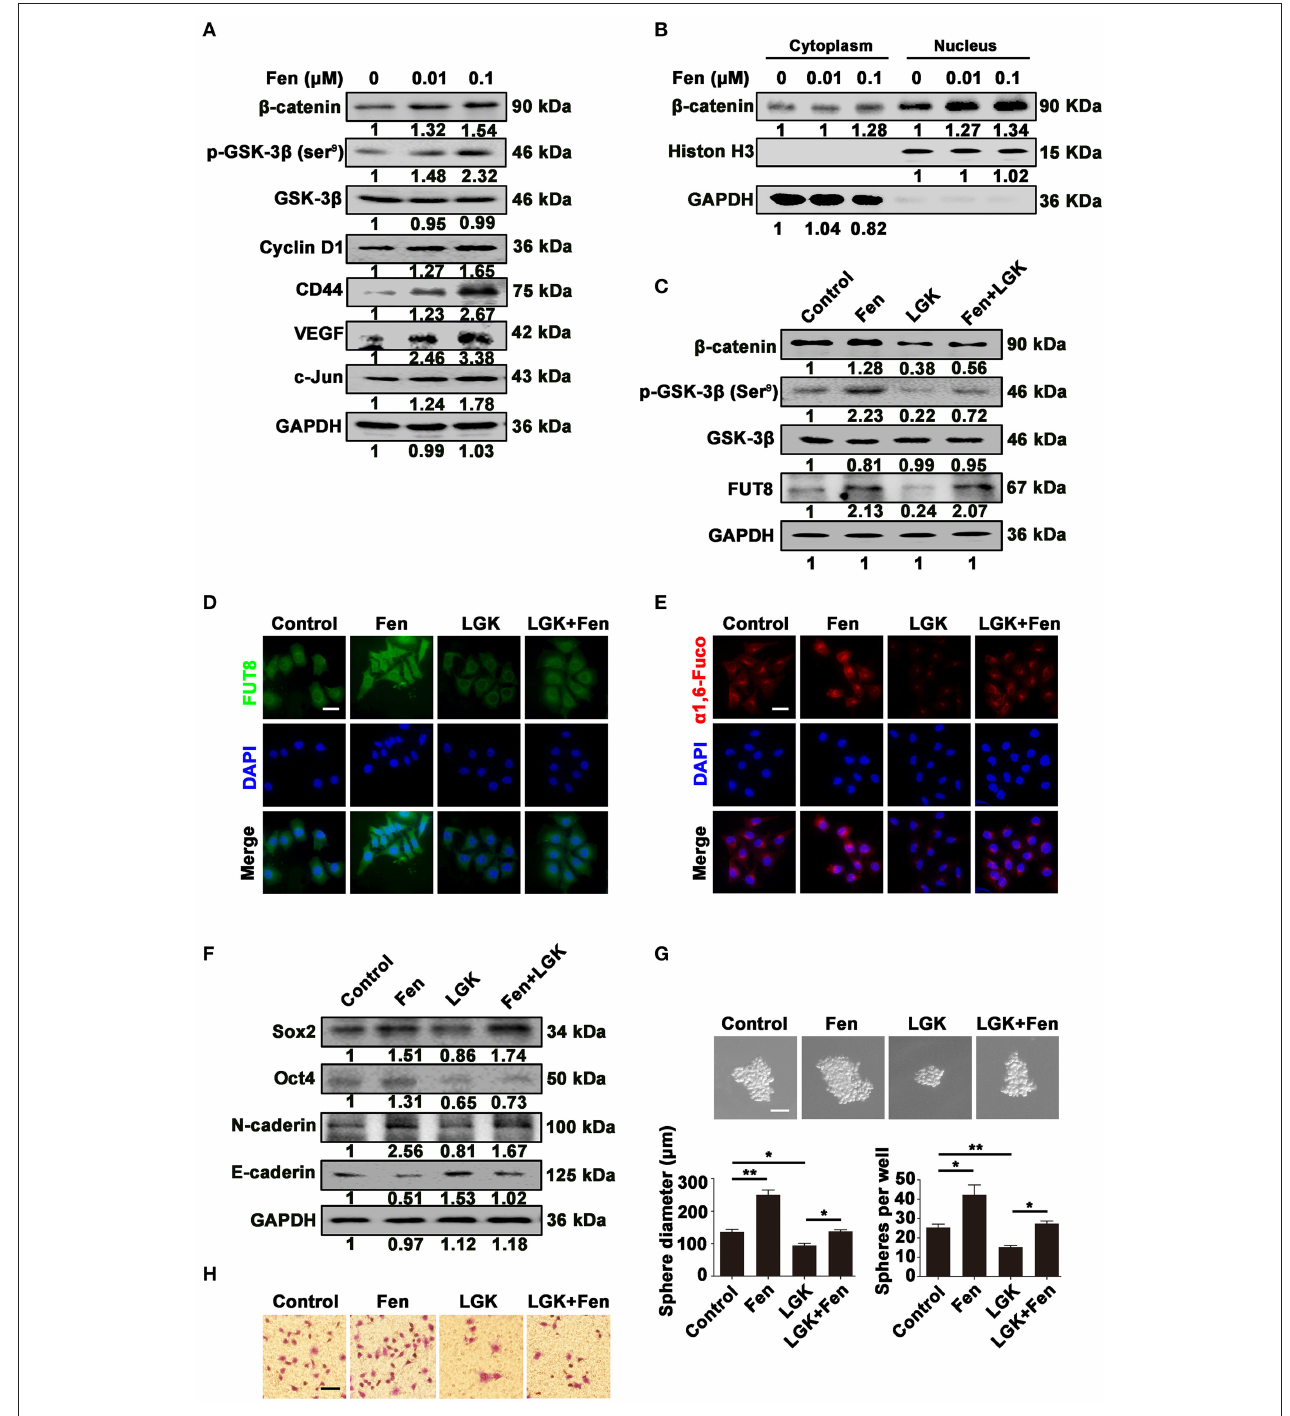
FIGURE 5 | Fentanyl upregulates α 1, 6-fucosylation level by activating Wnt/ β -catenin signaling pathway. (A) Western blot analysis for expression of β -catenin, p-GSK-3 β (Ser 9 ), GSK-3 β , Cyclin D1, CD44, VEGF and c-Jun after treatment with fentanyl (0, 0.01 µ M, 0.1 µ M) for 48 h. (B) Western blot analysis for expression of β -catenin in cytoplasm and nucleus after treatment with fentanyl. GAPDH and Histone H3 were used as cytoplasmic and nuclear control, respectively. (C) Western blot analysis for expression of β -catenin, p-GSK-3 β (Ser 9 ), GSK-3 β and FUT8 after treatment with fentanyl, LGK-974 and LGK-974 + fentanyl. (D,E) Representative immunofluorescent and Lectin fluorescent images of FUT8 and α 1, 6-fucosylation. (Scale bars = 50 µ m; Magnification, 400 × ). (F) Western blot analysis for Sox2, Oct4, N-cadherin and E-cadherin protein expression. (G) Images of MCF-7 cells tumor-spheres, observed under a microscope after treatment with fentanyl, LGK-974 and LGK-974 + fentanyl. (Scale bars = 50 µ m; Magnification, 200 × ). (H) Images of migrated MCF-7 cells were observed under a microscope. (Scale bars = 50 µ m; Magnification, 200 × ). Data are represented as mean ± SD ( n = 3). Statistical significant different in gene expression (* P < 0.05; ** P < 0.01).